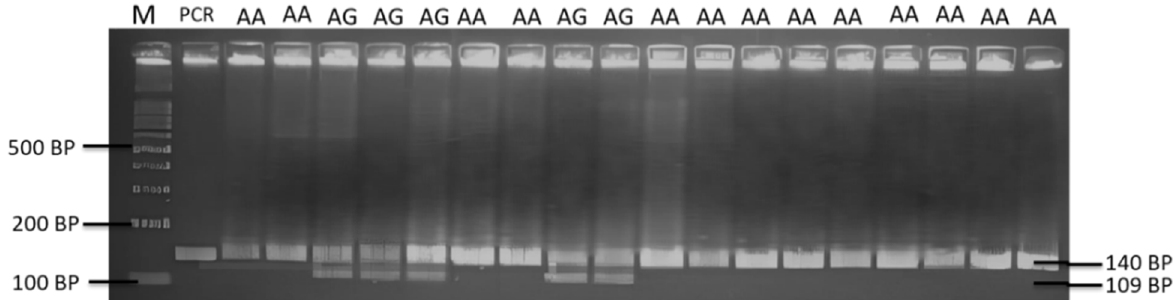
Fig. 3 The PCR–RFLP results for BMPR1B/ Ava II gene in MEGA sheep in 2% agarose gel were showed two genotype of AA-wildtype or Fec + / Fec + (140 bp) and AG-carrier or Fec + / Fec B (140 bp and 109 bp). PCR: amplicon (140 bp). M: DNA marker 100 bp